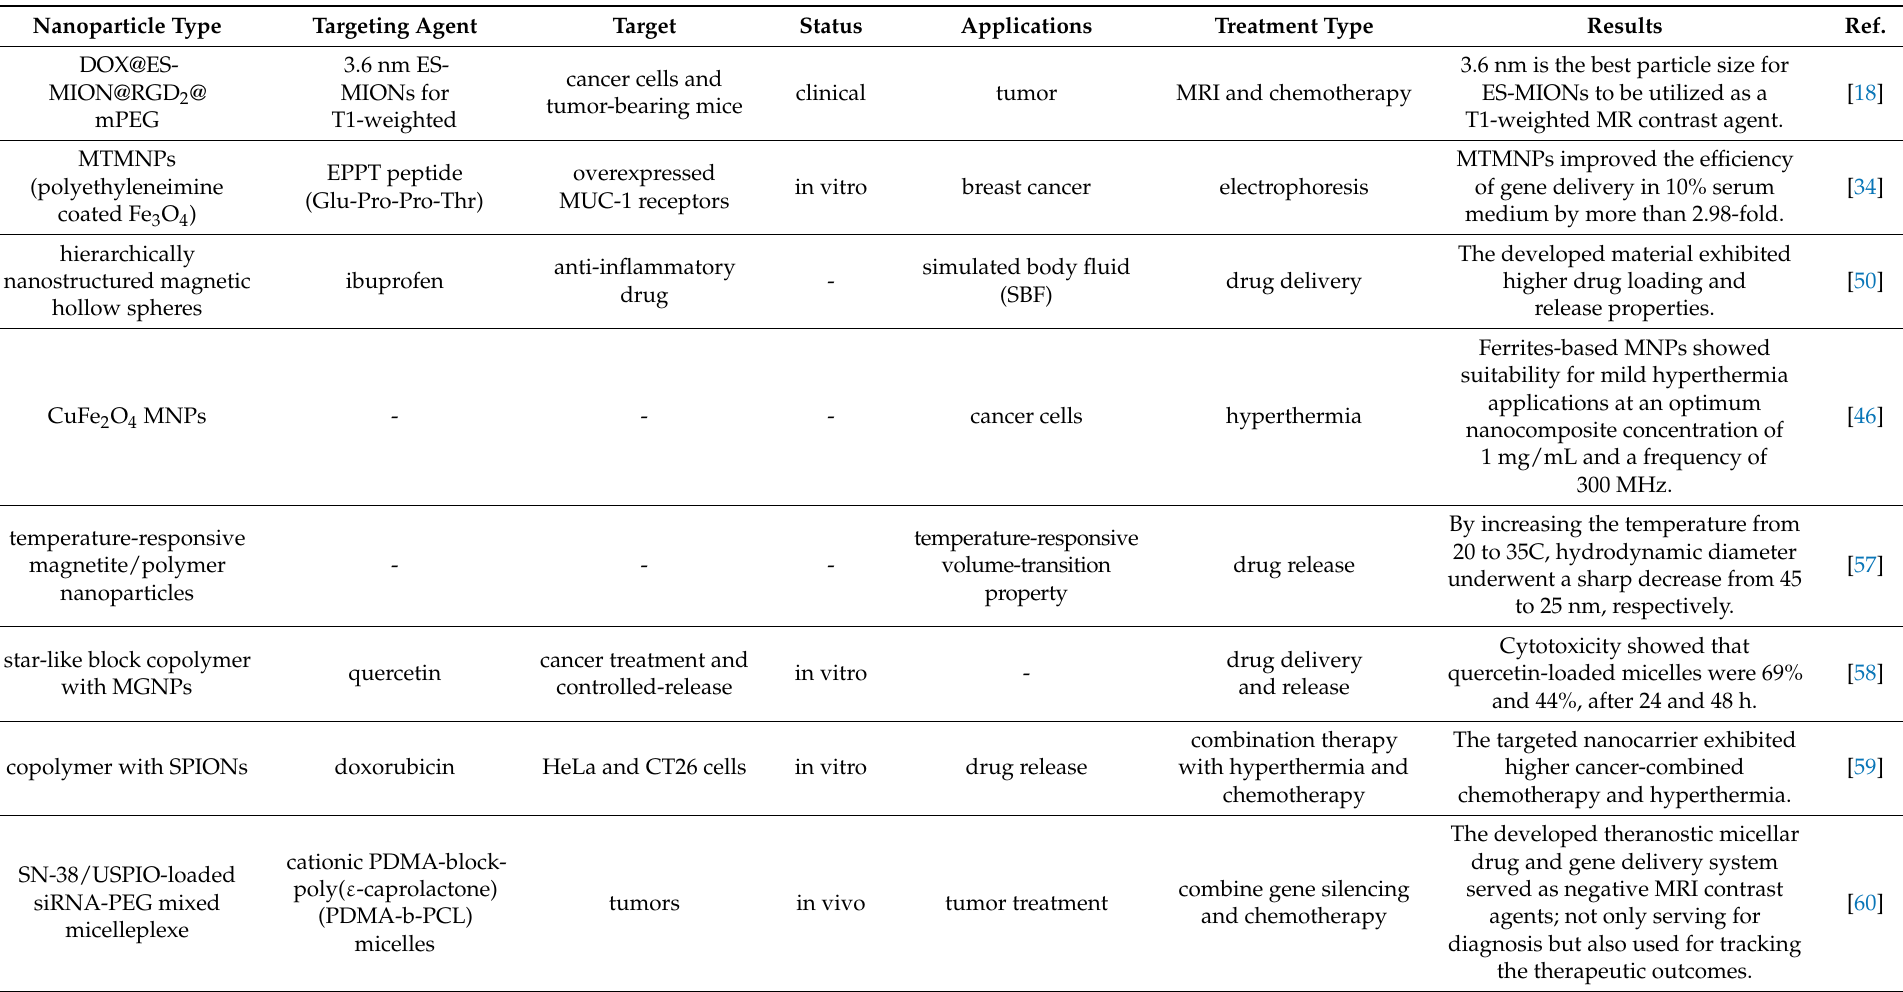
Table 1. The studies of the application of MNPs in cancer diagnosis and